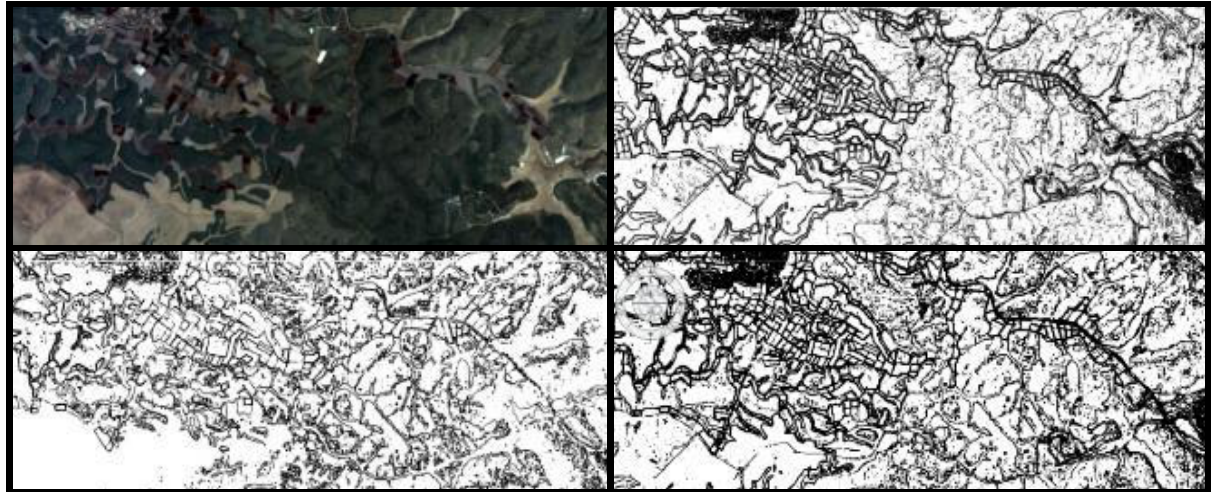
Figure 4 : Results of edge detection according to the stages of the method: original image (top left), edge detection in exposed areas (top right), edge detection in vegetation areas (bottom left), edge detection in final image (bottom